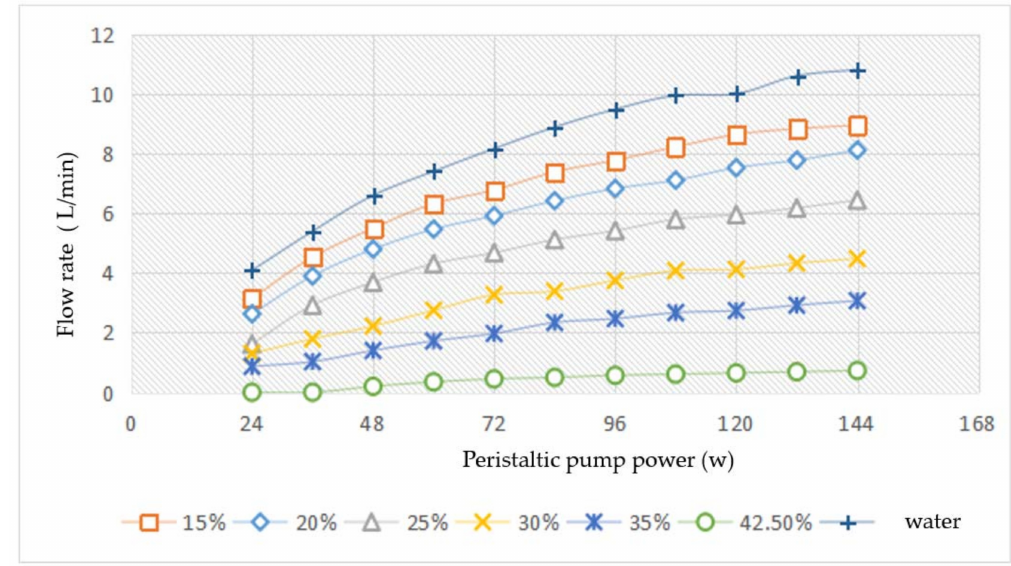
Figure 11. Relation between peristaltic pump power and flow rate for various concentrations of slurry.